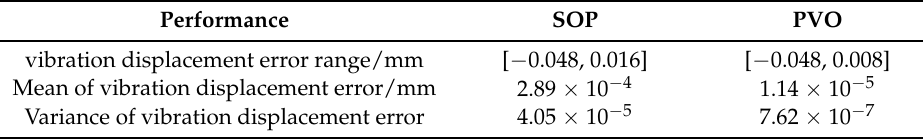
Table 1. Performance comparison among SOP and PVO